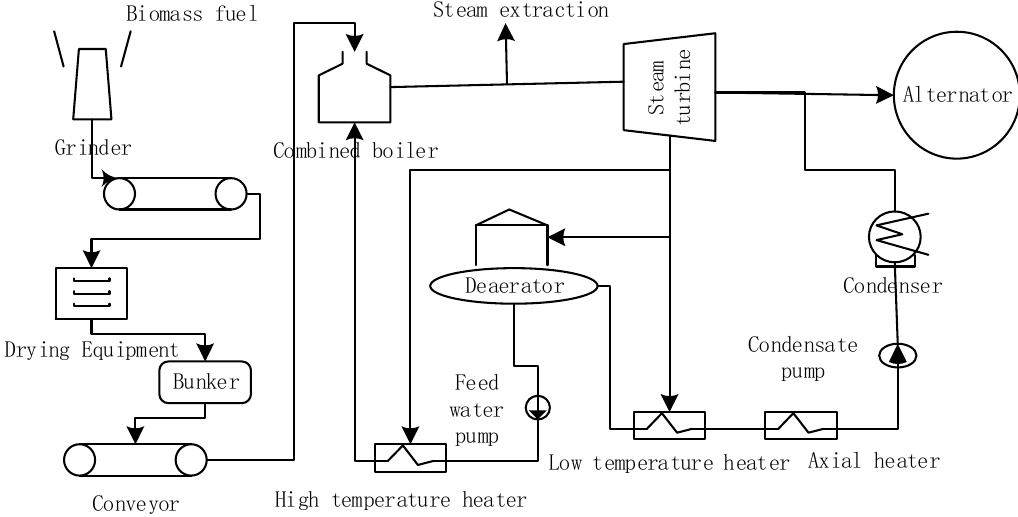
Figure 1. Flow chart of conventional biomass direct fired cogeneration system.